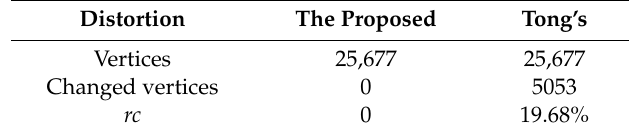
Table 9. Comparison results of lossless and non-lossless